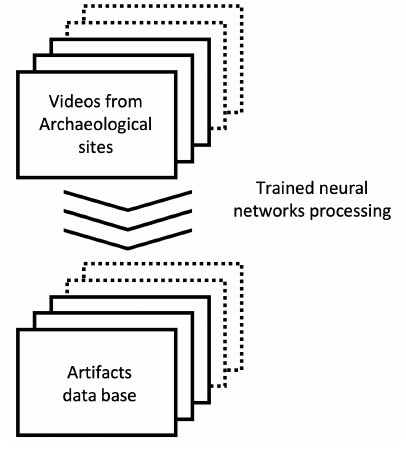
Figure 4: future use of trained neural